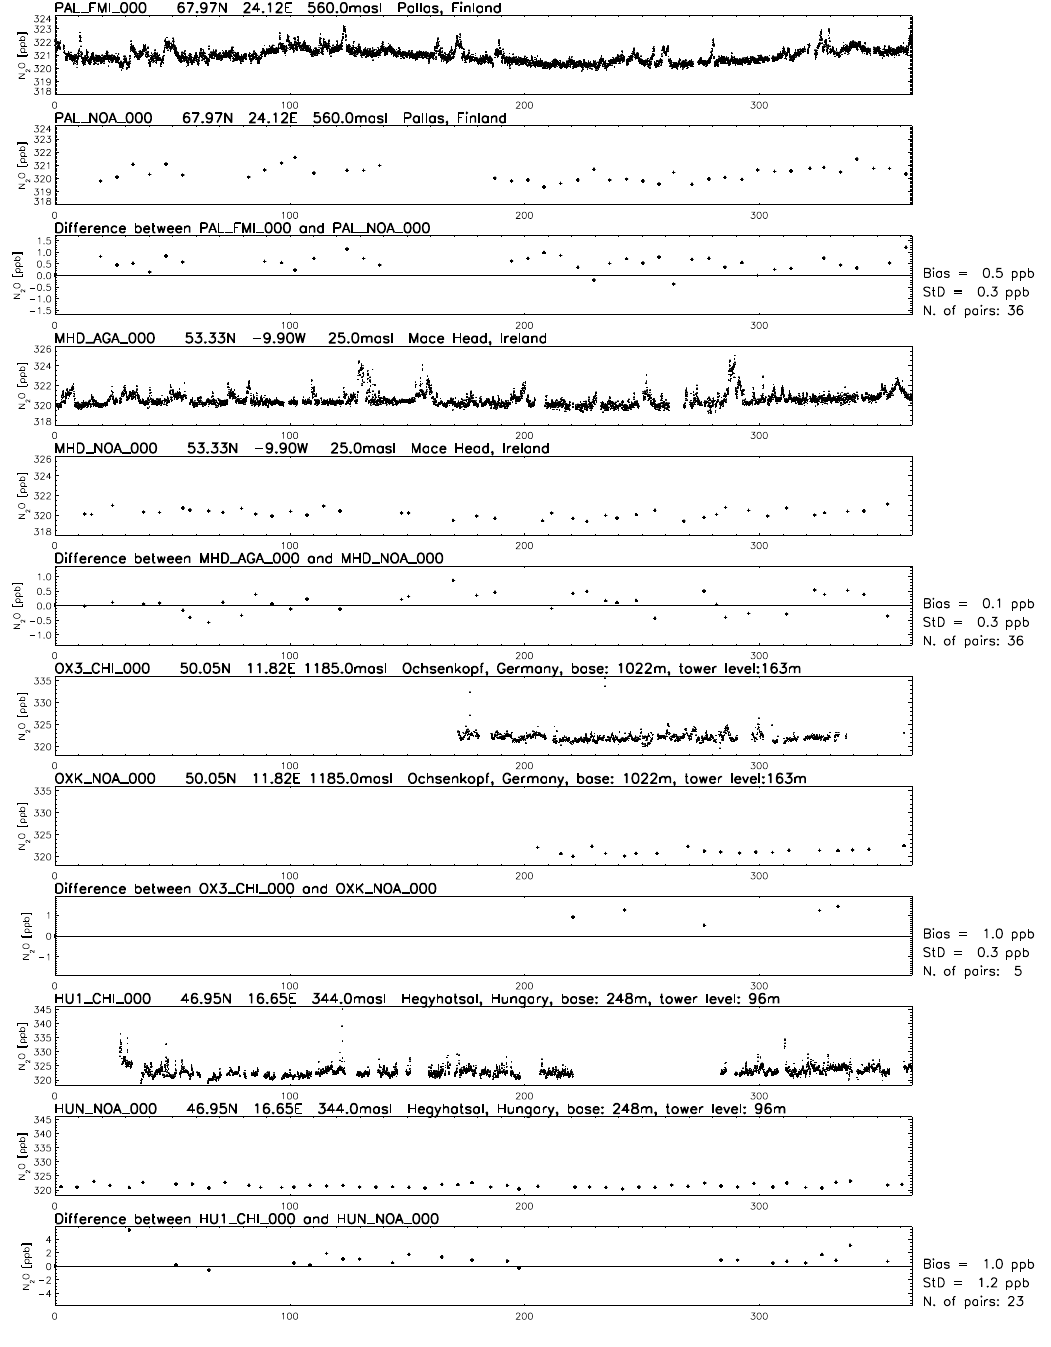
Fig. 1. N 2 O mixing ratio at the 4 locations where parallel measurements are available. For each location, the first panel represents continuous measurements, the second panel NOAA flask samples. Their difference of measurements coinciding within 1h is shown in the third panel. The calculated bias, standard deviation, and number of pairs are reported for each